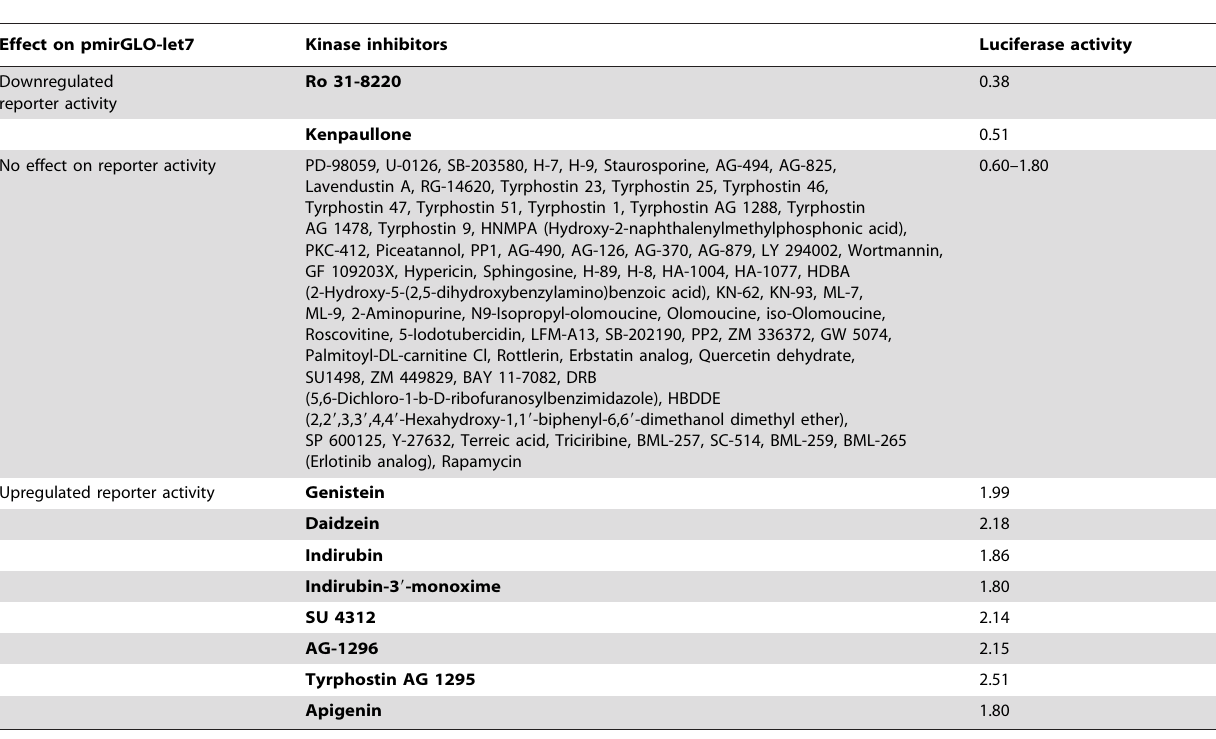
Table 1. Survey of let-7 levels using a kinase inhibitor